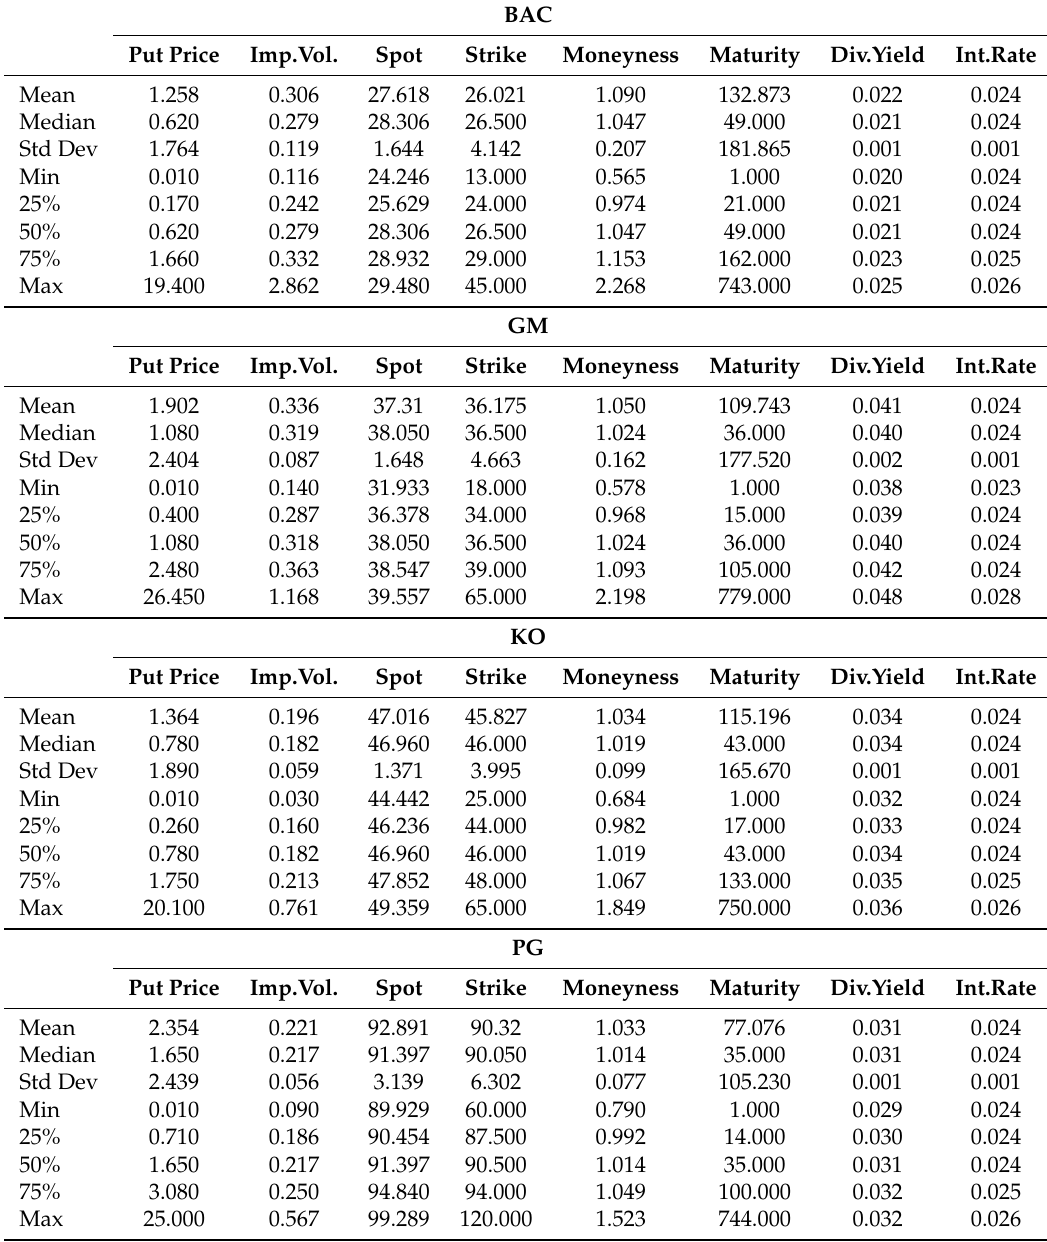
Table 3. Descriptive statistics per company.